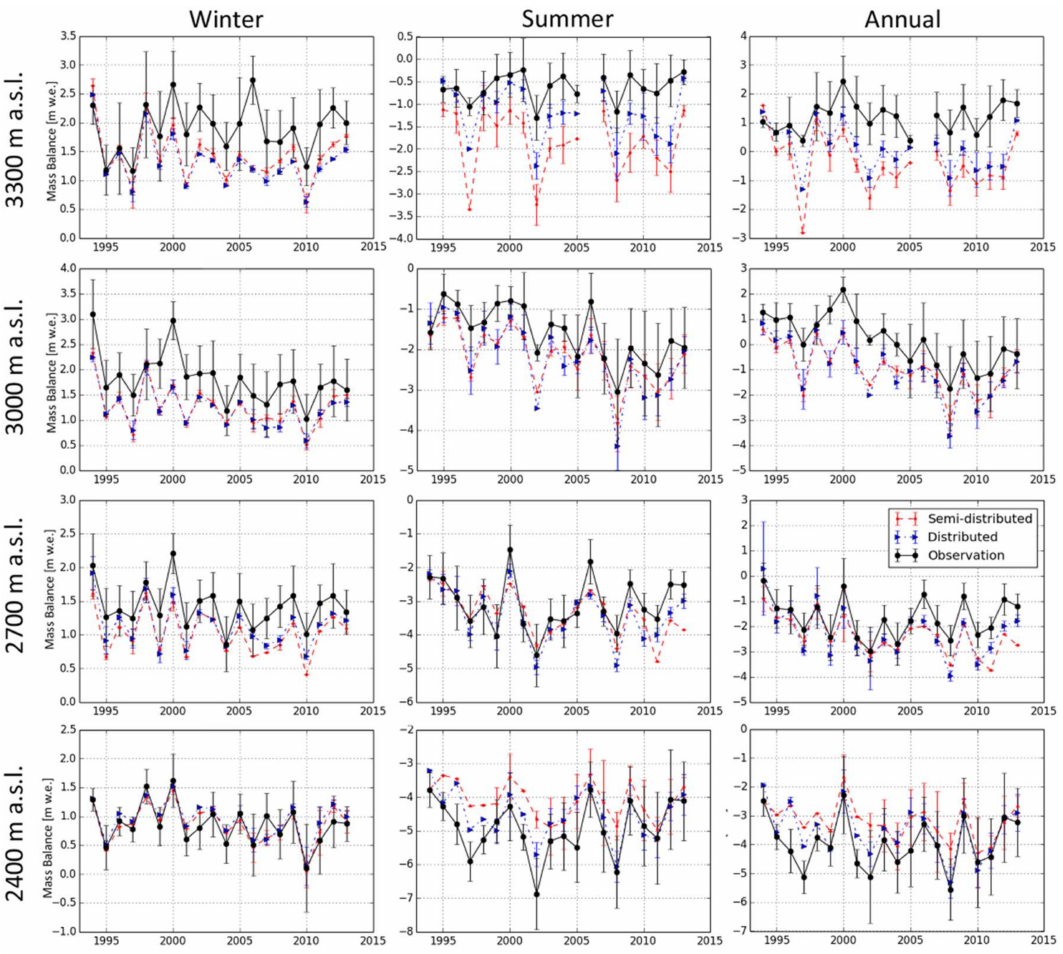
Figure 10. Temporal evolution of the observed and simulated (semi-distributed and distributed) SMB for the Argenti è re glacier for the four 300-m elevation bands for the period 1994–2013. The points show the average observation and simulation values for the same measurement locations, and the vertical bars show the standard deviations for those